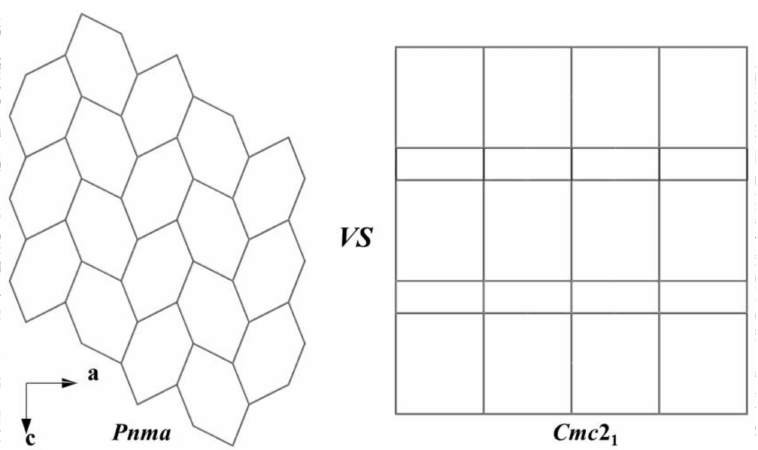
Figure 4. ( a ) Topological structure in Pnma space group with the BaS 8 units regarded as the nodes; ( b ) topological structure in Cmc 2 1 space group with BaS 8 units regarded as the nodes.